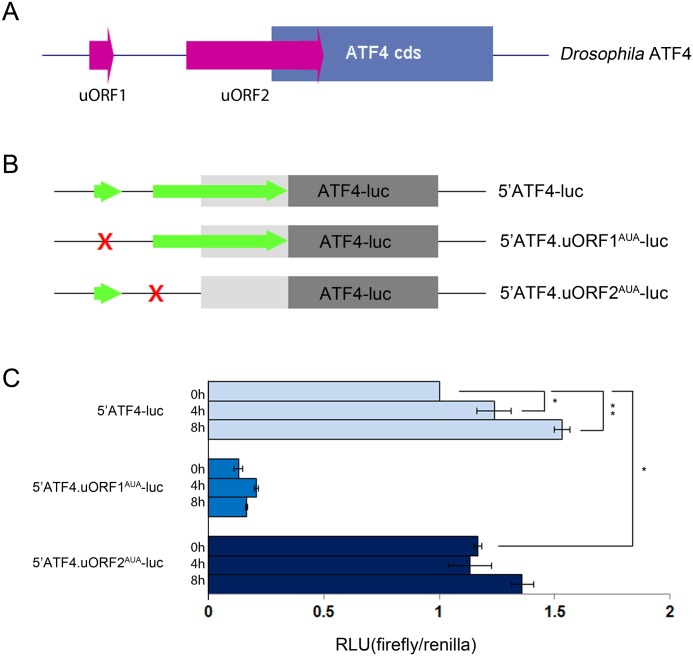
The uORFs of Drosophila ATF4 5′UTR mediate translation regulation.(A) Structure of the 5′ UTR of the Drosophila ATF4-RA mRNA. The two uORFs, such as uORF1 and uORF2, were present in the 5′ UTR. The uORF2 overlaps with the ATF4 ORF, but in a different reading frame. (B) The luciferase reporter construct used in this experiment. The green arrow represents the wild type version of uORF1 and uORF2, and the X indicates a mutation in the initiation codon at each uORF. (C) Drosophila S2 cells were transfected with the indicated ATF4-Luc plasmid and a control Renilla luciferase plasmid. The transfected cells were treated with 1mM of DTT for the indicated time points, 0, 4, and 8 h. Relative light units (RLU) indicates a ratio of firefly luciferase activity normalized with Renilla luciferase activity, and each value was derived from three independent transfections. Error bars show ± s.e.m. *p<0.05, **p<0.005.